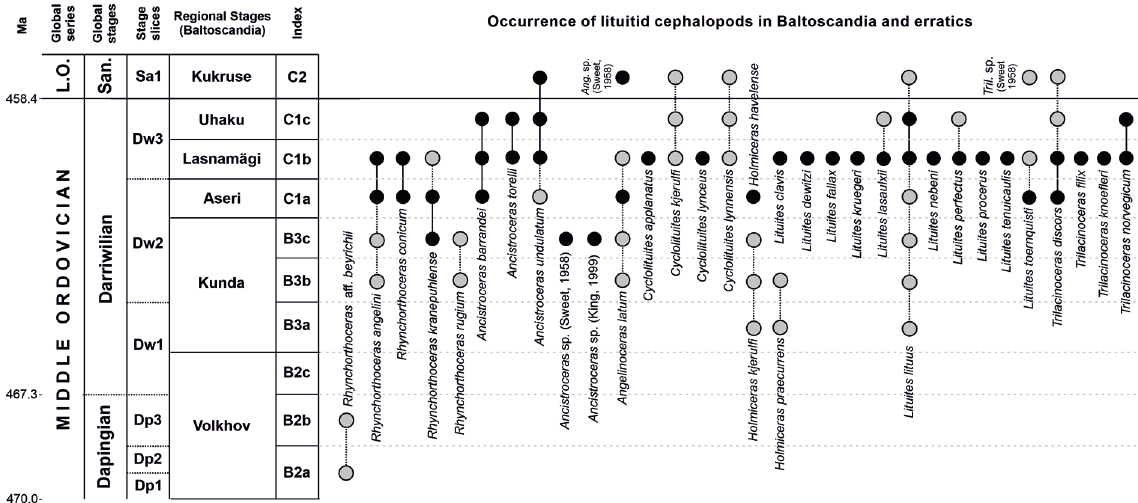
Fig. 4. Stratigraphic distribution of lituitid taxa in Ordovician strata of Baltoscandia and Ordovician erratics; black circles indicate unambiguous presence, grey circles indicate possible presence. Species with unknown stratigraphic occurrence are excluded from the scheme. Stratigraphic chart after Ebbestad & Högström (2007) and Meidla et al. (2014); stage slices after Bergström et al.